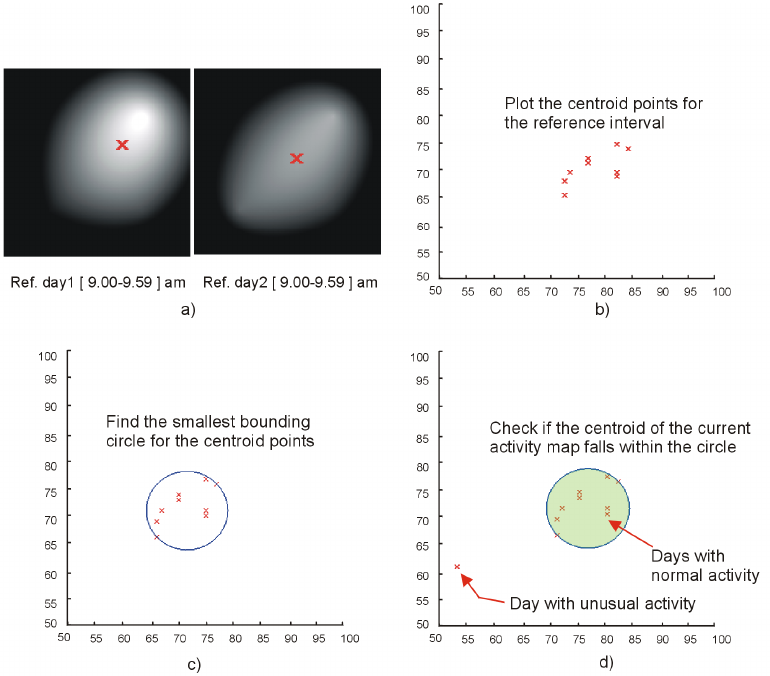
Figure 7. The proposed method to detect deviations from the previously recorded activity patterns: ( a ) Choose a reference interval (e.g., 7–12 days) with normal activity and create activity maps for each one hour time slice; ( b ) Plot the centroid points of the activity maps for each time slice across the reference interval; ( c ) Find the smallest circle that bounds the centroid points for the reference interval. The area delimited by this circle defines normal or typical activity patterns; ( d ) Check if the centroid of the current activity maps falls inside the normal activity area.